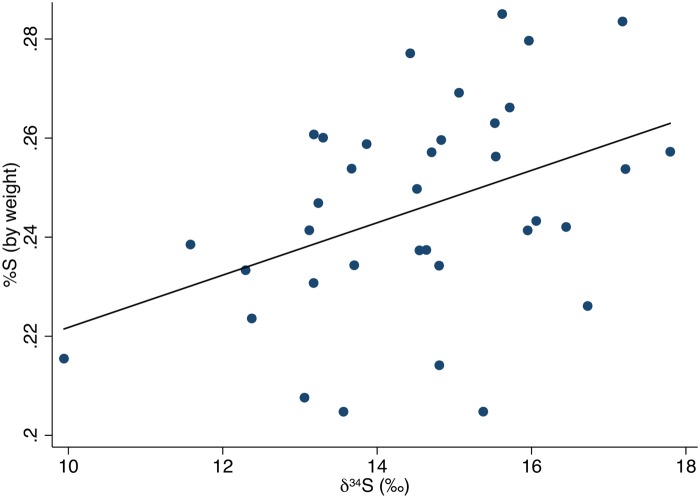
δ34S values and %S by weight with fitted regression line (y = 0.005x + 0.169, p = 0.028).